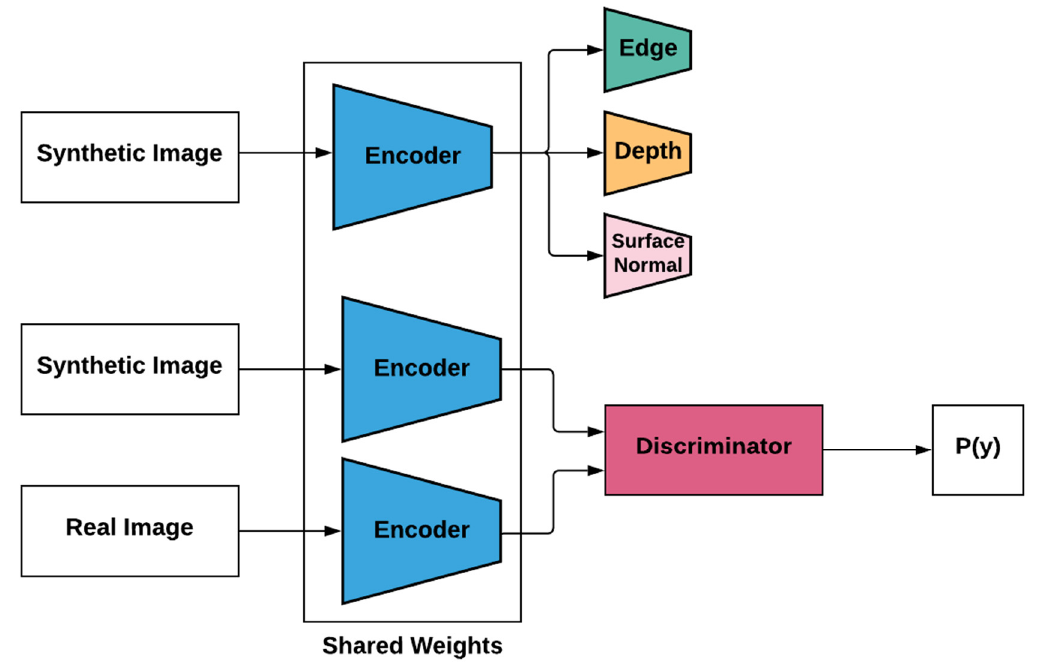
Figure 11. An illustration of the algorithm used in [81]. An encoder is given multiple tasks. It must create an encoding of a synthetic image that can then be used to predict the edge, depth, and surface normal properties of that image. This encoding must also be able to fool a discriminator which is given an encoding of a synthetic and a real image.